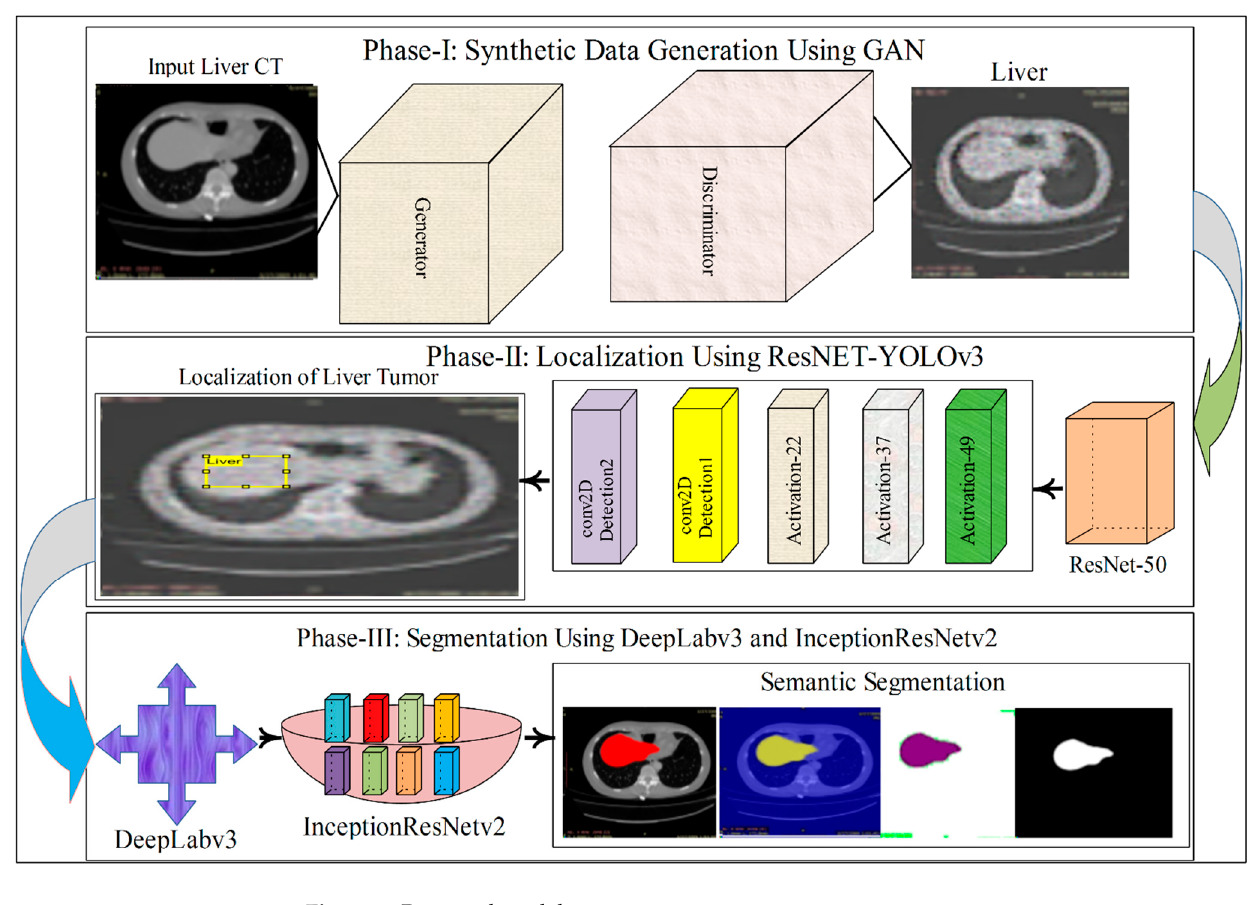
Figure 1. Proposed model.